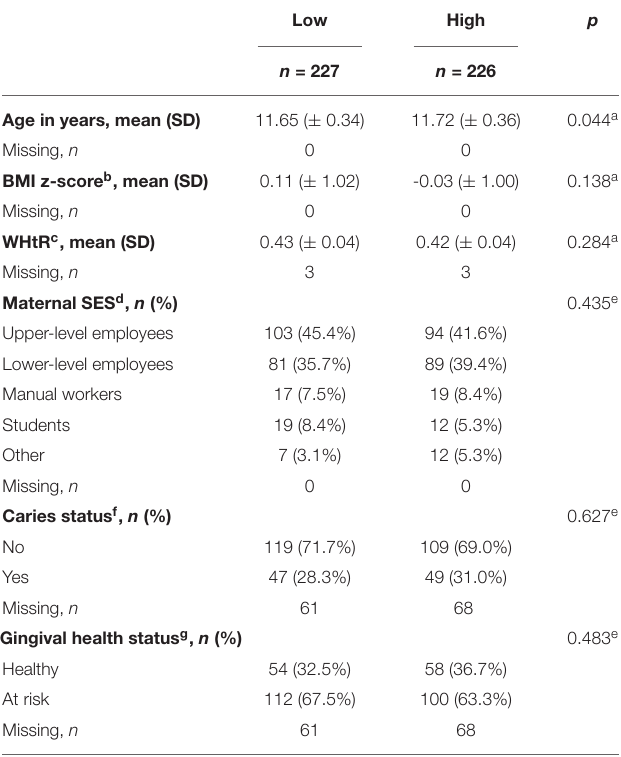
TABLE 1 | Participant characteristics by low and high sweet treat consumption ( n =